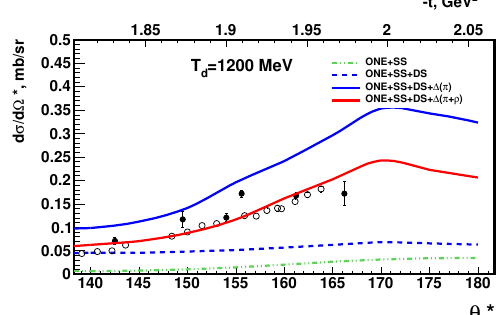
Figure 4: The angular dependence of the differential cross section at the deuteron energy at T